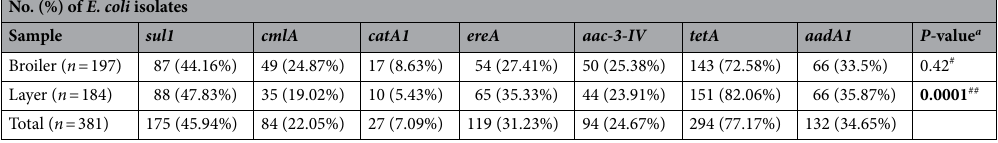
Table 4. Overall prevalence of non-beta-lactam ARGs among the investigated E. coli ( n = 381) isolates in relation to type of hens (broiler or layer) in Sylhet division of Bangladesh. a P values were calculated using a two-way analysis of variance (ANOVA) without replication. P values < 0.05 are highlighted in bold. # Variance between broiler and layer chickens. ## Variance among the antibiotic resistant genes.